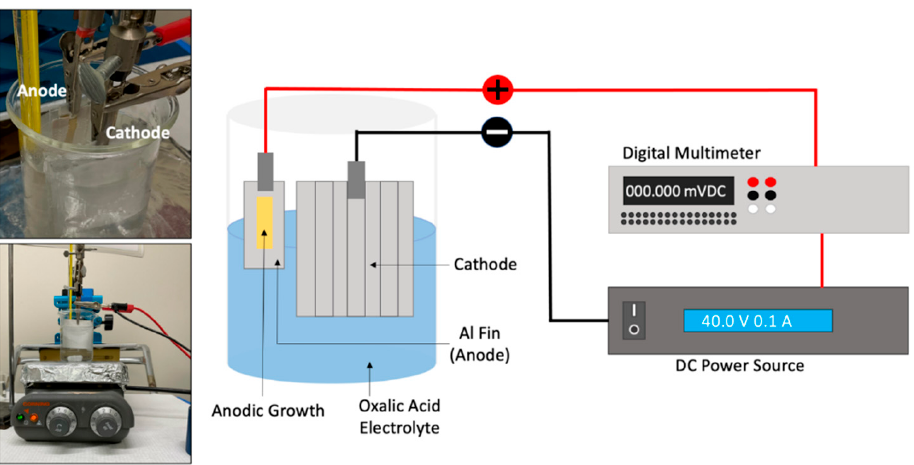
Figure 2. Experimental setup used to produce an anodic porous structure on the surface of the aluminum alloy sample. From left to right: oxalic acid bath containing anode and cathode along the hot plate used to maintain bath at a given temperature, and representation of the connections from the anode and cathode to DC power source and multimeter.